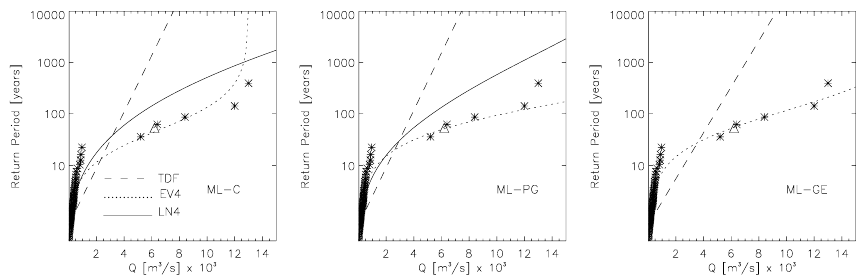
Fig. 2. Applied models to the Jucar River. Stars are the sample plotting positions given by the E formula. Triangle represents the X H = 6200m 3 s − 1 plotting position. Figures correspond to each estimation method: ML-C (left), ML-PG (central) and ML-GE